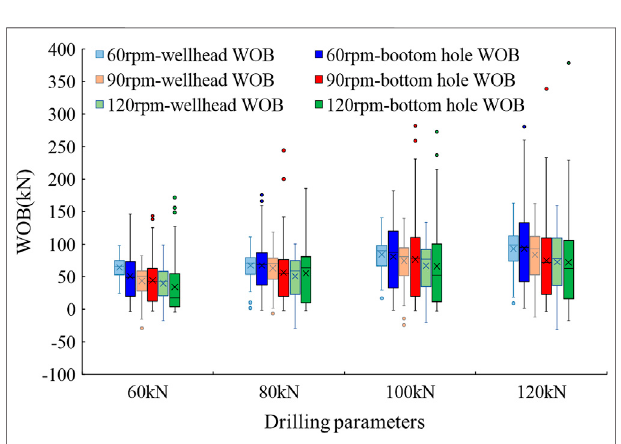
FIGURE 13 | Distribution of wellhead WOB and bottom hole